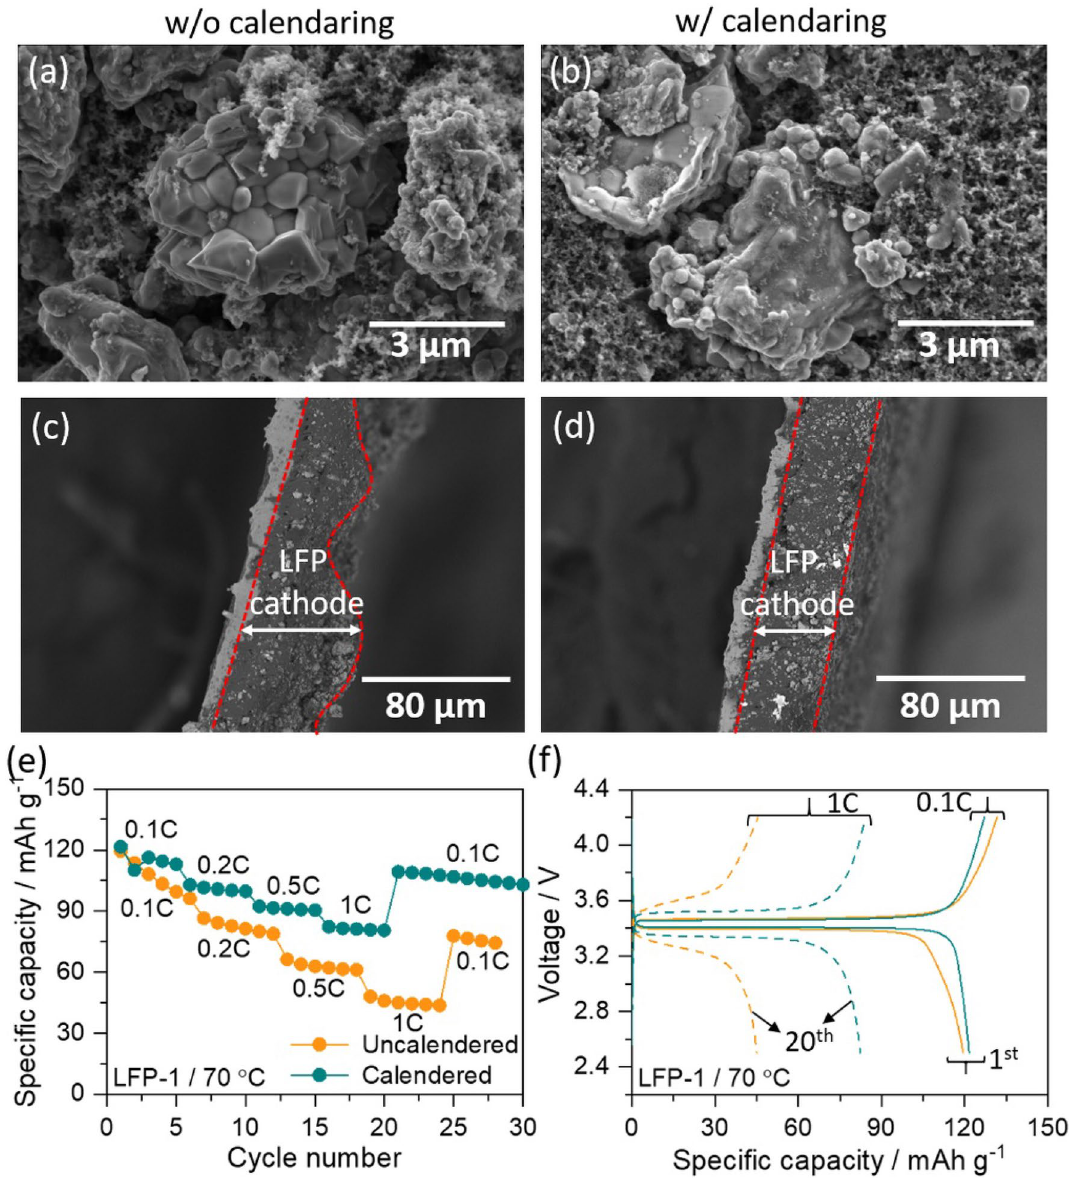
Figure 2. ( a ) and ( b ) are the SEM images, ( c ) and ( d ) are the cross-sectional SEM images of LFP-1 cathode before and after calendaring process, ( e ) comparative rate capability curve and ( f ) the corresponding charge/ discharge curves of Li/SPNE/LFP cell using LFP-1 measured at 70 °C at different current rates, from 0.1C to